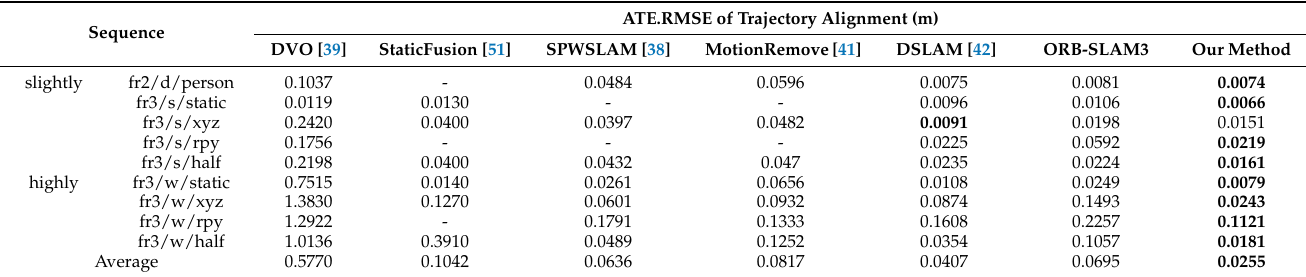
Table 3. Comparison of the ATE.RMSE on the TUM benchmark.